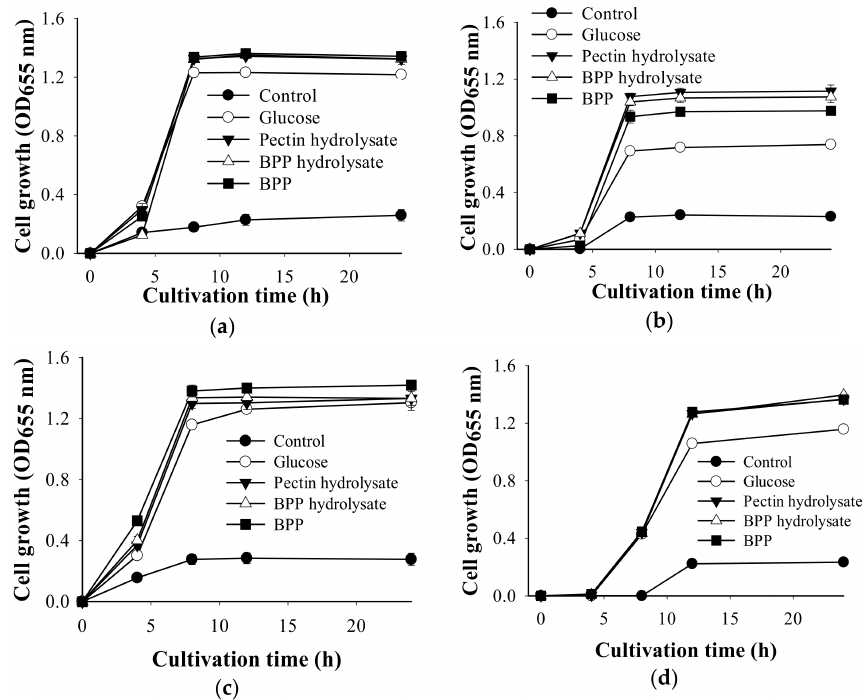
Figure 7. Effect of BPB hydrolysate, pectin hydrolysate, BPB, and glucose on the growth of lactic acid bacteria strains: ( a ) L. paracasei subsp. paracasei BCRC14023; ( b ) L. rhamnosus BCRC16000; ( c ) L. rhamnosus BCRC10494; ( d ) L. lactis BCRC10791. The error bars represent standard deviations ( n =